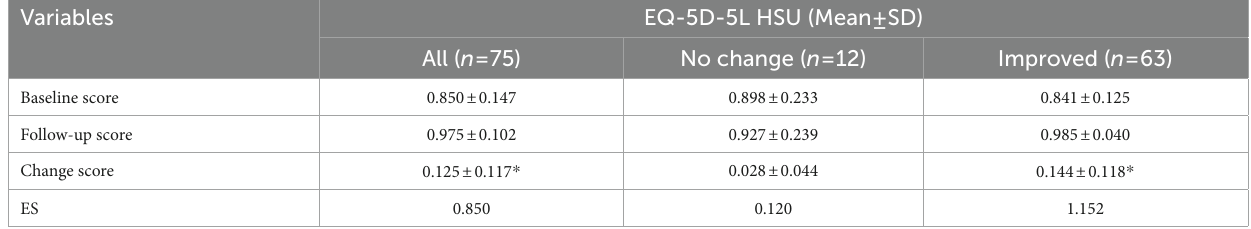
TABLE 3 Responsive to SAQ of the EQ-5D-5L HSU at four-week after PCI.